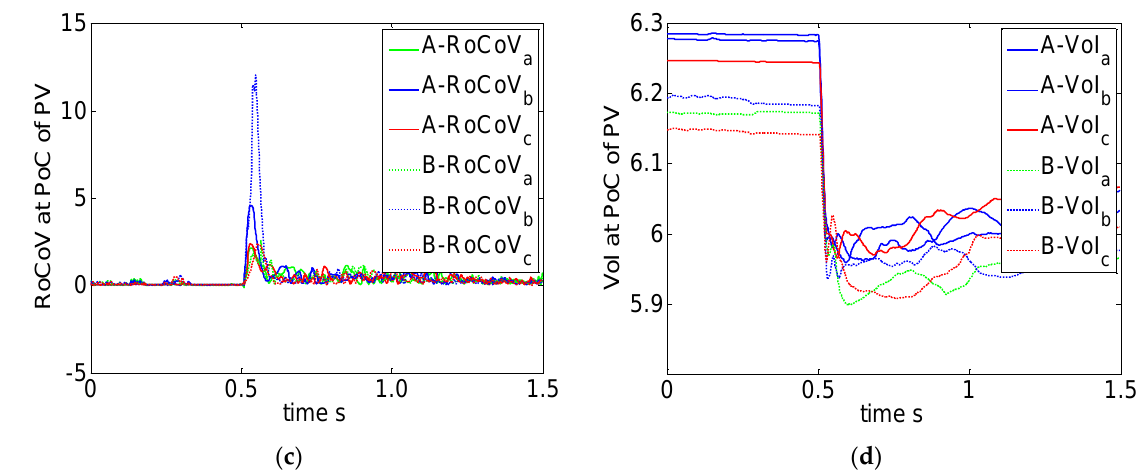
Figure 12. Load increment in MG ( a ) Active power generation of DGs and grid, scenario A and B; ( b ) Reactive power generation of DGs and grid, scenario A and B; ( c ) Rate of change of the voltages at the PoC of PV, scenario A and B; ( d ) The VoI index at the PoC of PV, scenario A and B.